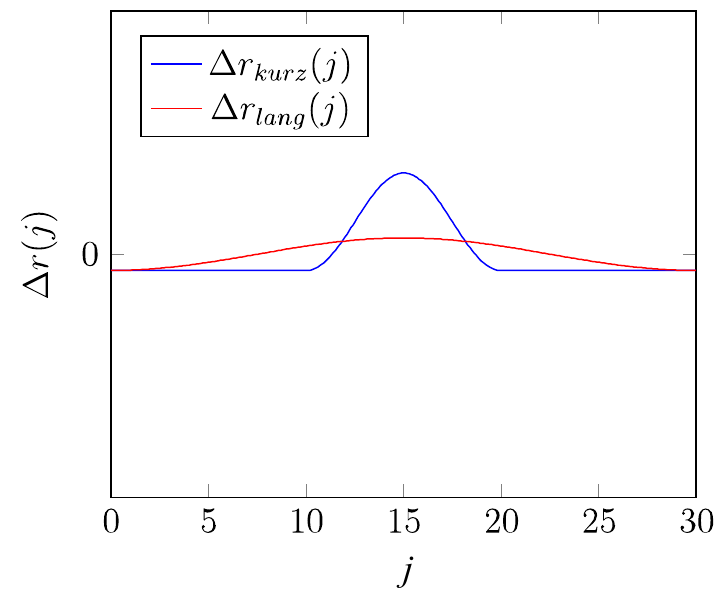
Figure 7. Δ r ( j ) for short and long wrinkles. Figure 7. ∆ r ( j ) for short and long